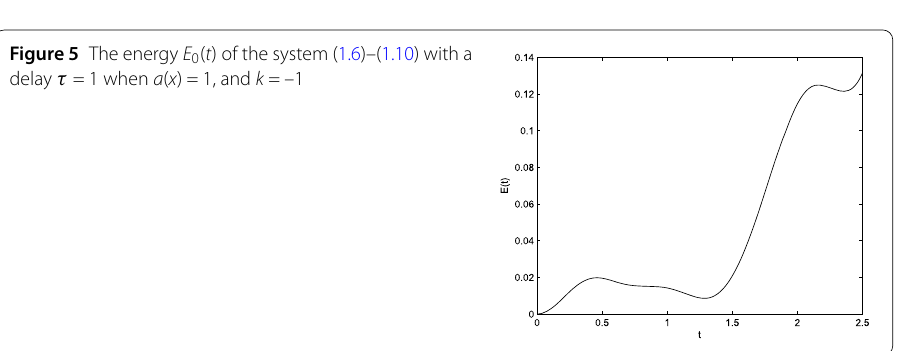
Figure 4 2-d solutions of the wave equation (1.6)–(1.10) with a time-delay τ = 1 when a ( x ) = 1 and k = –1, at different times: t = 0, ... ,2